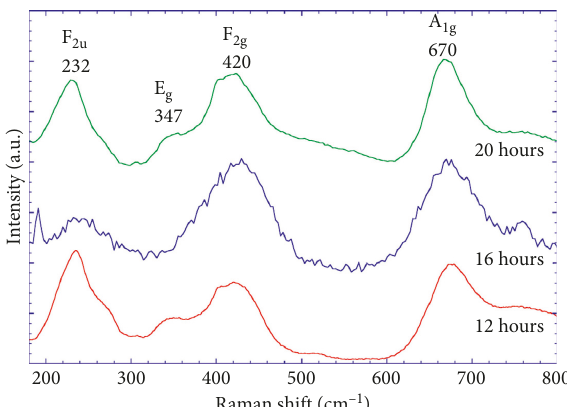
Figure 3: Raman spectroscopy of Li